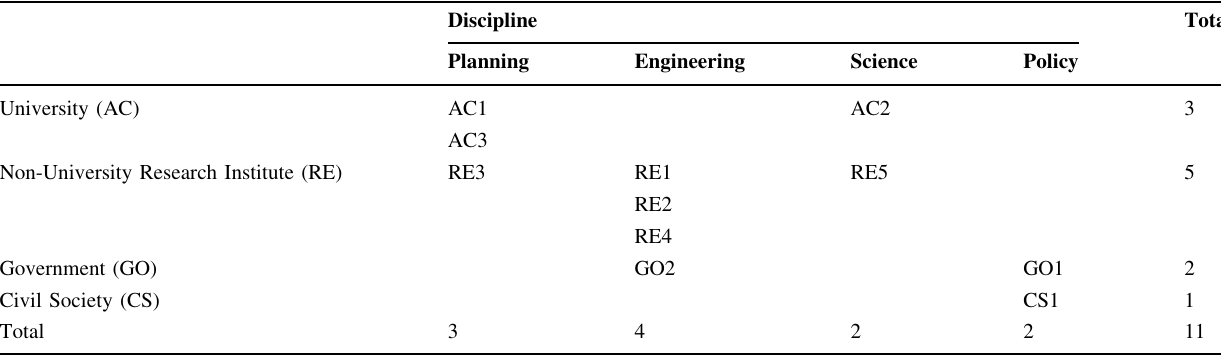
Table 1 List of the experts interviewed about nature-based solutions (NBS) between December 2019 and January